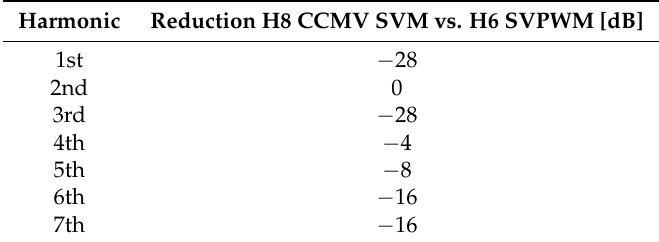
Table 4. Harmonic content comparison between H8 CCMV SVM and H6 SVPWM.